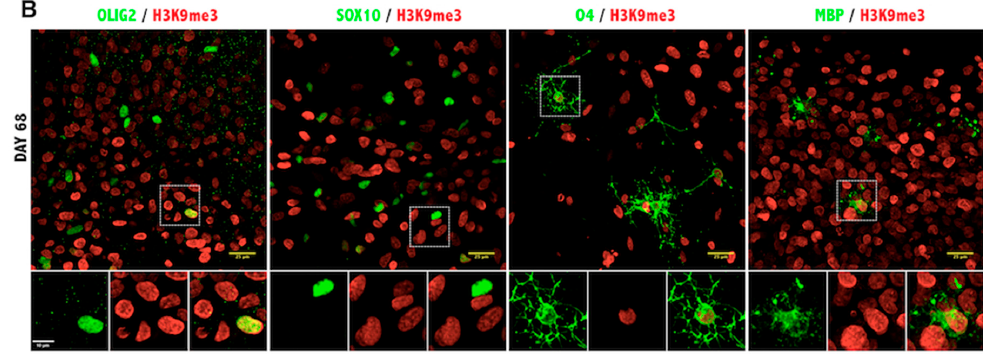
Figure 5. Immunofluorescence analysis of histone H3 lysine 9 trimethylation in iPSC-derived oligodendrocyte lineage cells. ( A ) Representative images of Day 8 of the oligodendrocyte differentiation protocol co-stained for NSC markers SOX1, NESTIN and the H3K9me3 antibody; ( B ) Images from Day 68 of differentiation co-stained for oligodendrocyte markers OLIG2, SOX10, O4, MBP and H3K9me3 antibody. Scale bar = 25 µm. The magnified view of the broken line box area appears as the inset with the individual channels and the merged image. Scale bar = 10 µm; ( C ) Quantitation of the immunofluorescence signal as the mean gray value in cells expressing the indicated markers ( left ) or in all DAPI-positive cells per field ( right ). Results are represented as the mean with the SD. * p < 0.05; **** p < 0.0001.